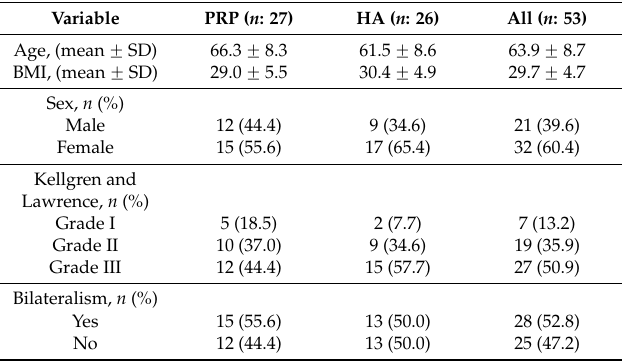
Table 2. Baseline characteristics of the patients.